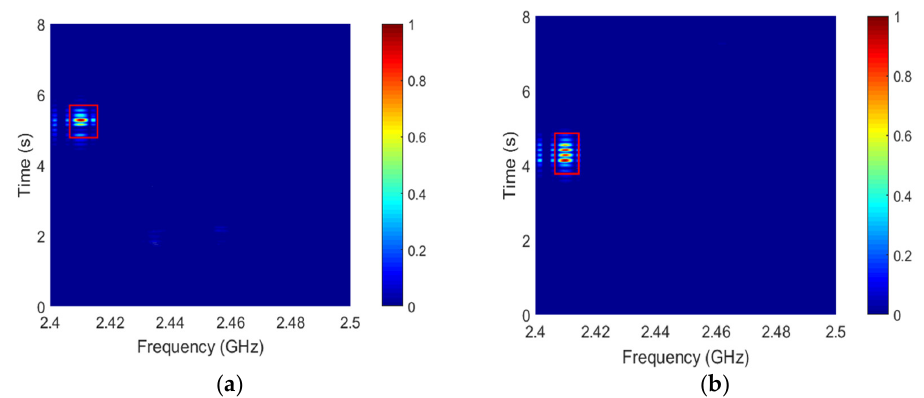
Figure 22. The results for the HOC method indoors at distances of ( a ) 5 m and ( b ) 10 m.